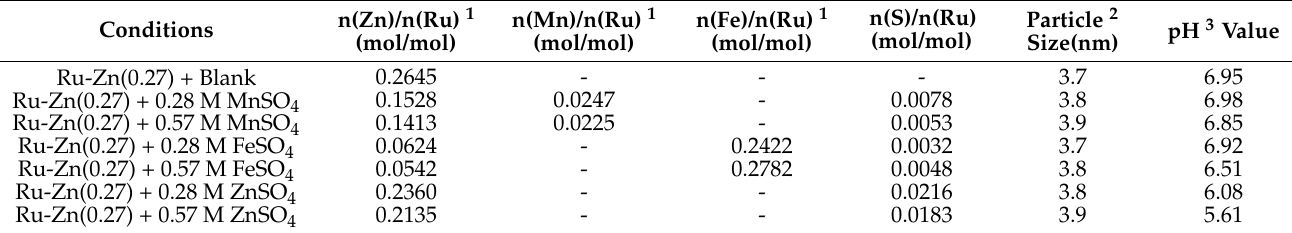
Table 3. Composition and particle size of monometallic Ru before and after catalytic experiments with different amounts of reaction modifiers as well as the pH value of slurry.